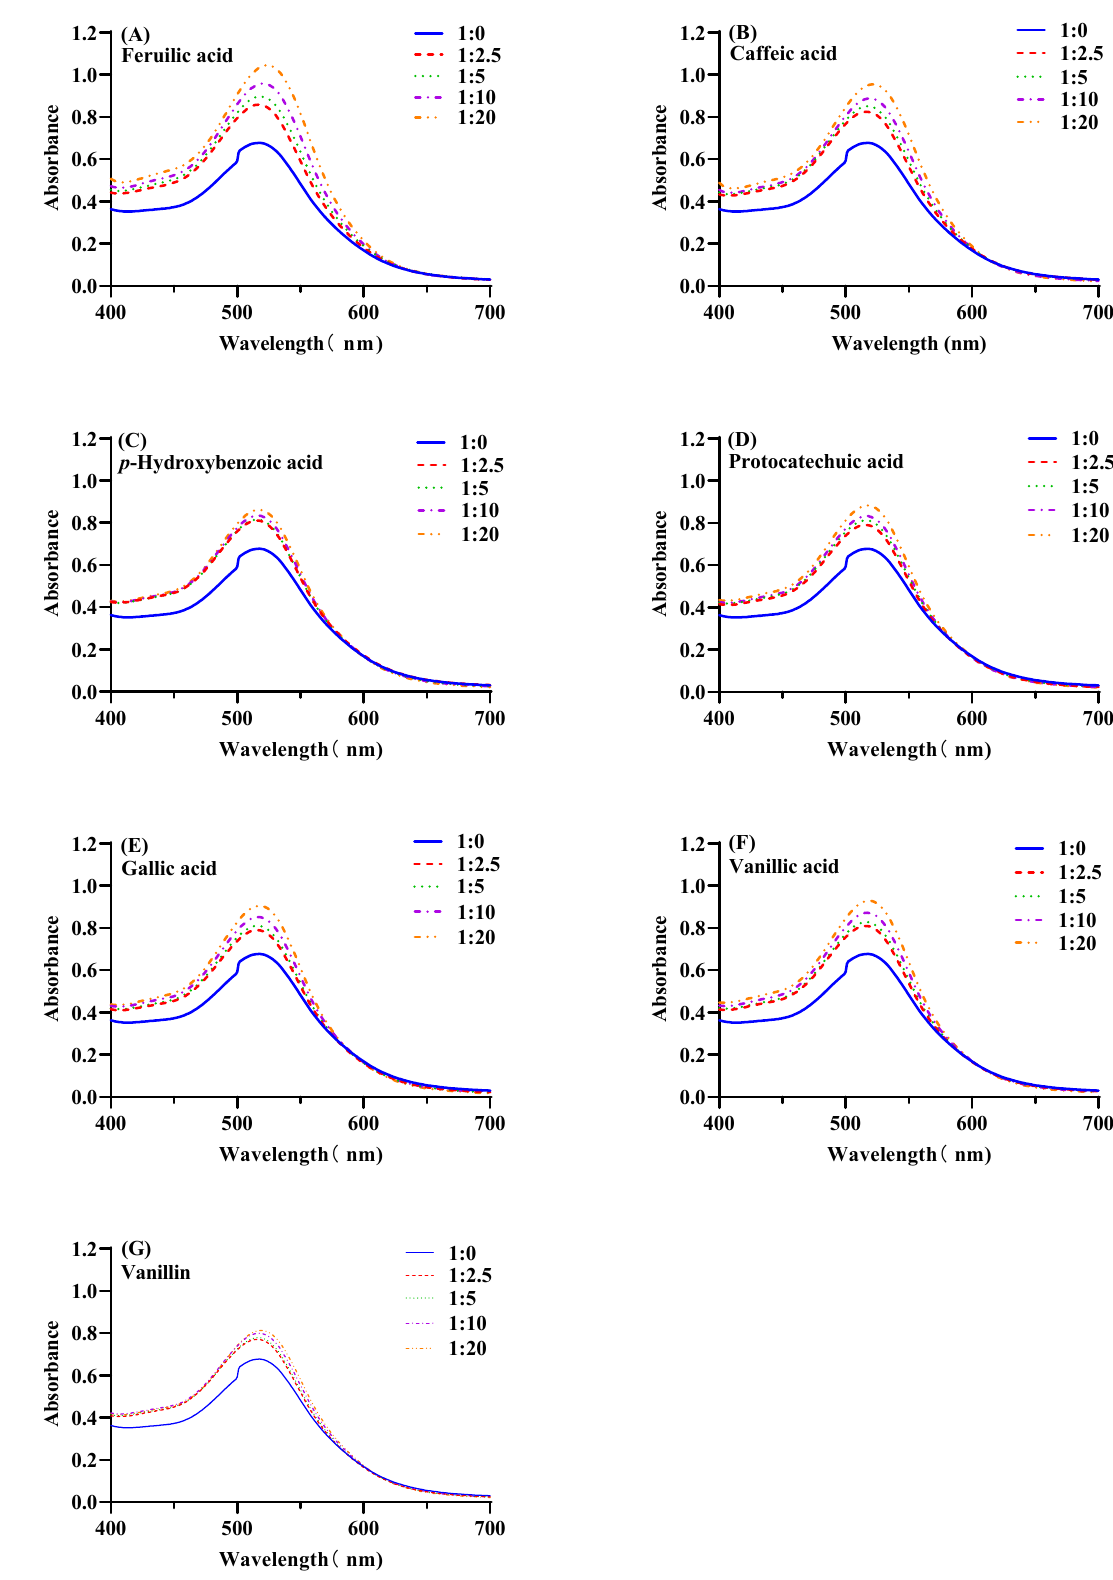
Figure 1. Visible absorption spectra of the mulberry anthocyanin co-pigmentation with different co-pigments and concentration at 20 ◦ C and pH 3.5 in the range of 400–700 nm (( A ): FA; ( B ): CA; ( C ): HBA; ( D ): PA; ( E ): GA; ( F ): VA; ( G ): VN).